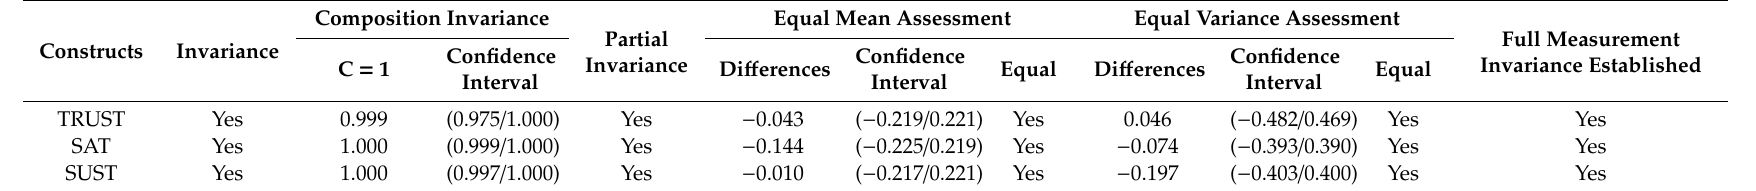
Table 6. Results of invariance measurement testing using permutation.